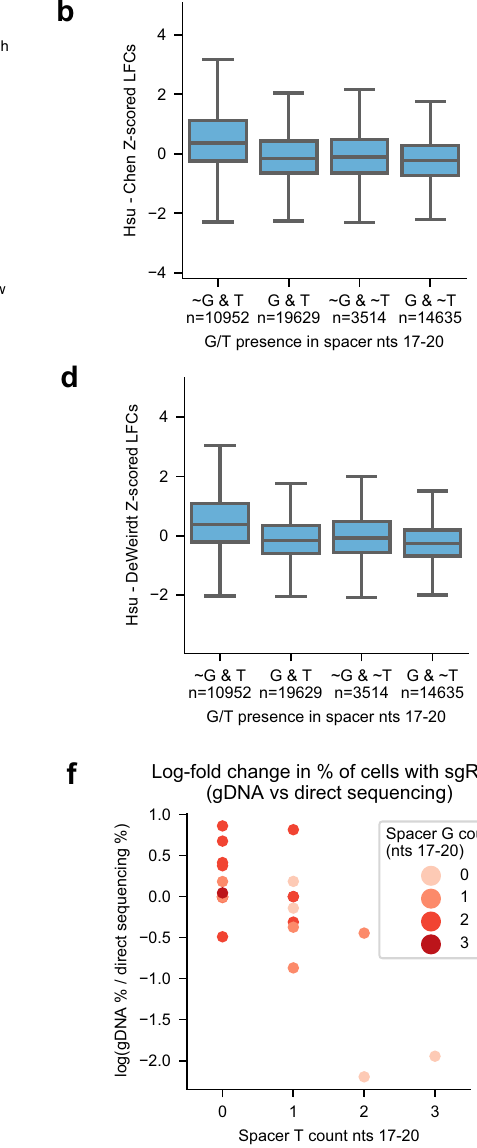
representthe50thpercentileofdata. c Boxplotofthedifferenceinz-scorelog-fold changes between sgRNAs screened with the Hsu versus Chen tracrRNA as a func- tionofG/Tabundanceinpositions17-20ofeachspacersequence.Boxminimaand maxima represent the 25th and 75th percentile, whisker minima and maxima represent the 25th and 75th percentile minus and plus 1.5× the interquartile range respectively, and the box centers represent the 50th percentile of data. d Same as ( b ) but for the Hsu and DeWeirdt tracrRNAs. e Same as ( c ) but for the Hsu and DeWeirdt tracrRNAs. f Data from Mimitou et al. Comparison of sgRNA relative abundancewhenreadoutviagDNAordirectsequencing.SpacersarebinnedbyG/ T abundance in positions 17 – 20. Source data are provided as a Source Data fi